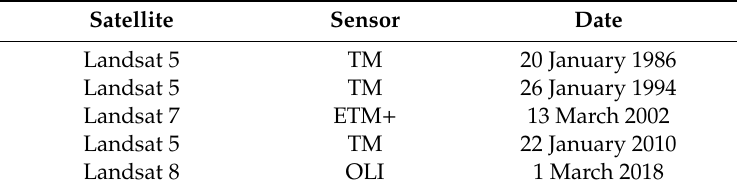
Table 2. Satellite imagery used for the remote sensing